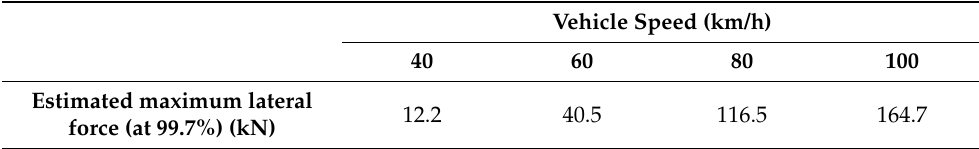
Table 5. Estimated maximum lateral force between the pivot and the bogie centre bowl of the freight wagon with 20t axle load running on the straight track with irregularities.